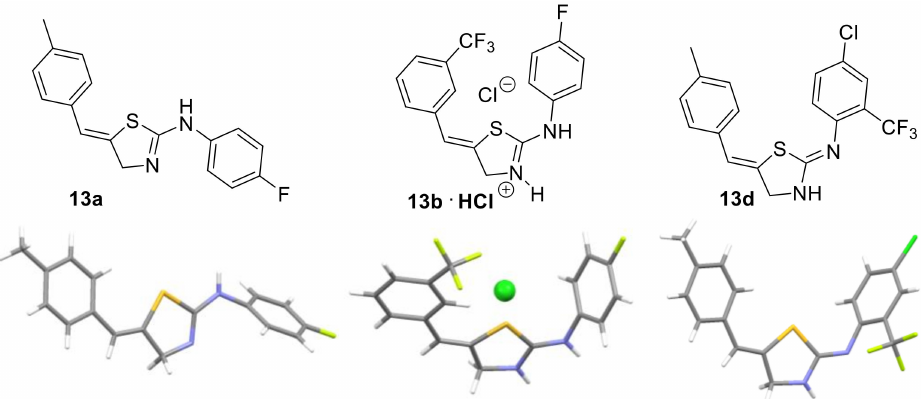
Figure 2. X-ray crystallographic study on selected